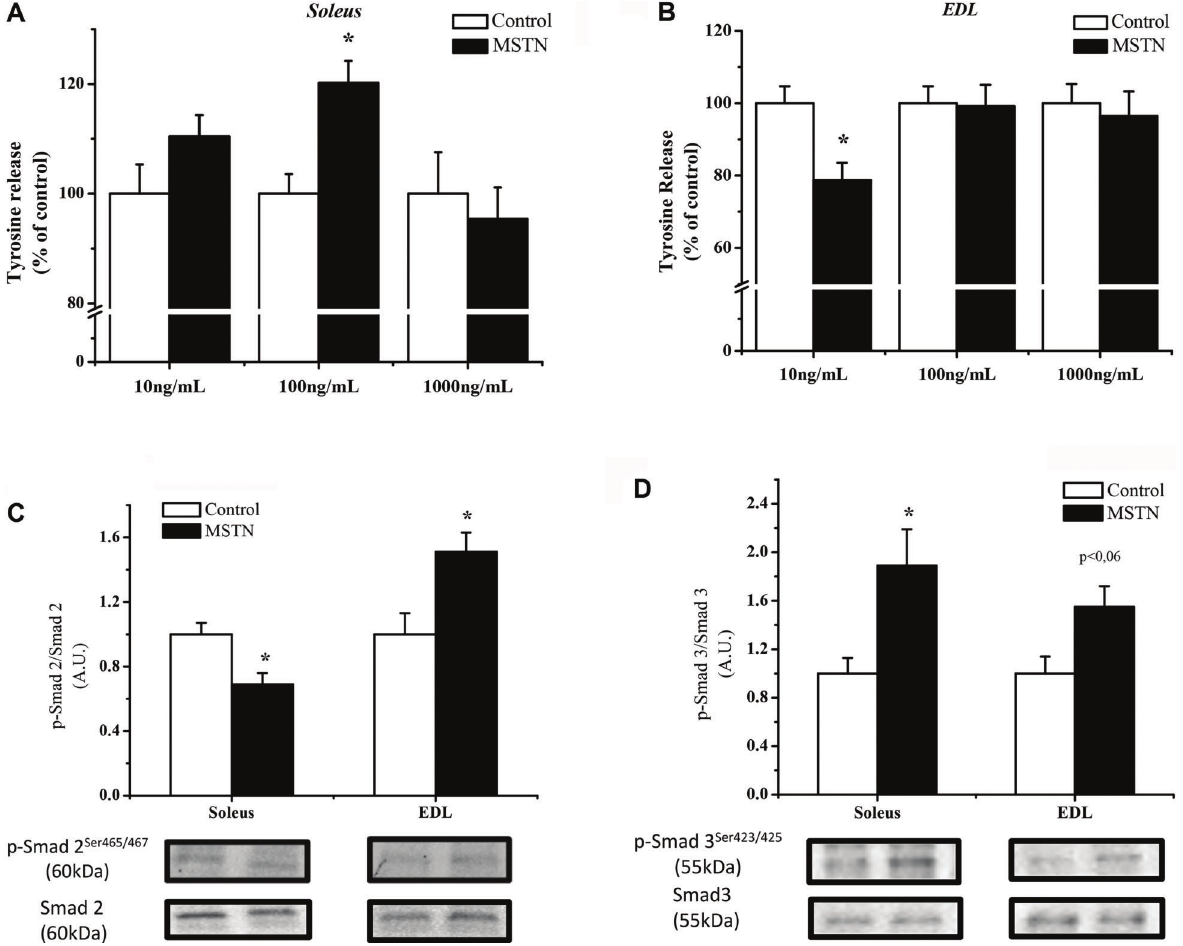
Figure 1. Overall proteolysis in ( A ) soleus and ( B ) extensor digitorum longus (EDL) muscles from rats incubated with myostatin (MSTN) for 4 h at different concentrations. Data are reported as means ± SE (n=7). *P o 0.05 MSTN vs Control, which is considered 100% ( t -test). The control values of released tyrosine are (nmol (cid:1) mg – 1 (cid:1) 2h – 1 ): 0.302 ± 0.016, 0.514 ± 0.020, and 0.465 ± 0.035 for soleus, and 0.268 ± 0.012, 0.439 ± 0.021, 0.370 ± 0.020 for EDL at doses of 10, 100, and 1000 ng/mL, respectively. Phosphorylation status of Smad2 ( C ) and Smad3 ( D ) from soleus (100 ng/mL) and EDL (10 ng/mL) incubated with MSTN. A.U.: arbitrary units. *P o 0.05 MSTN vs Control ( t